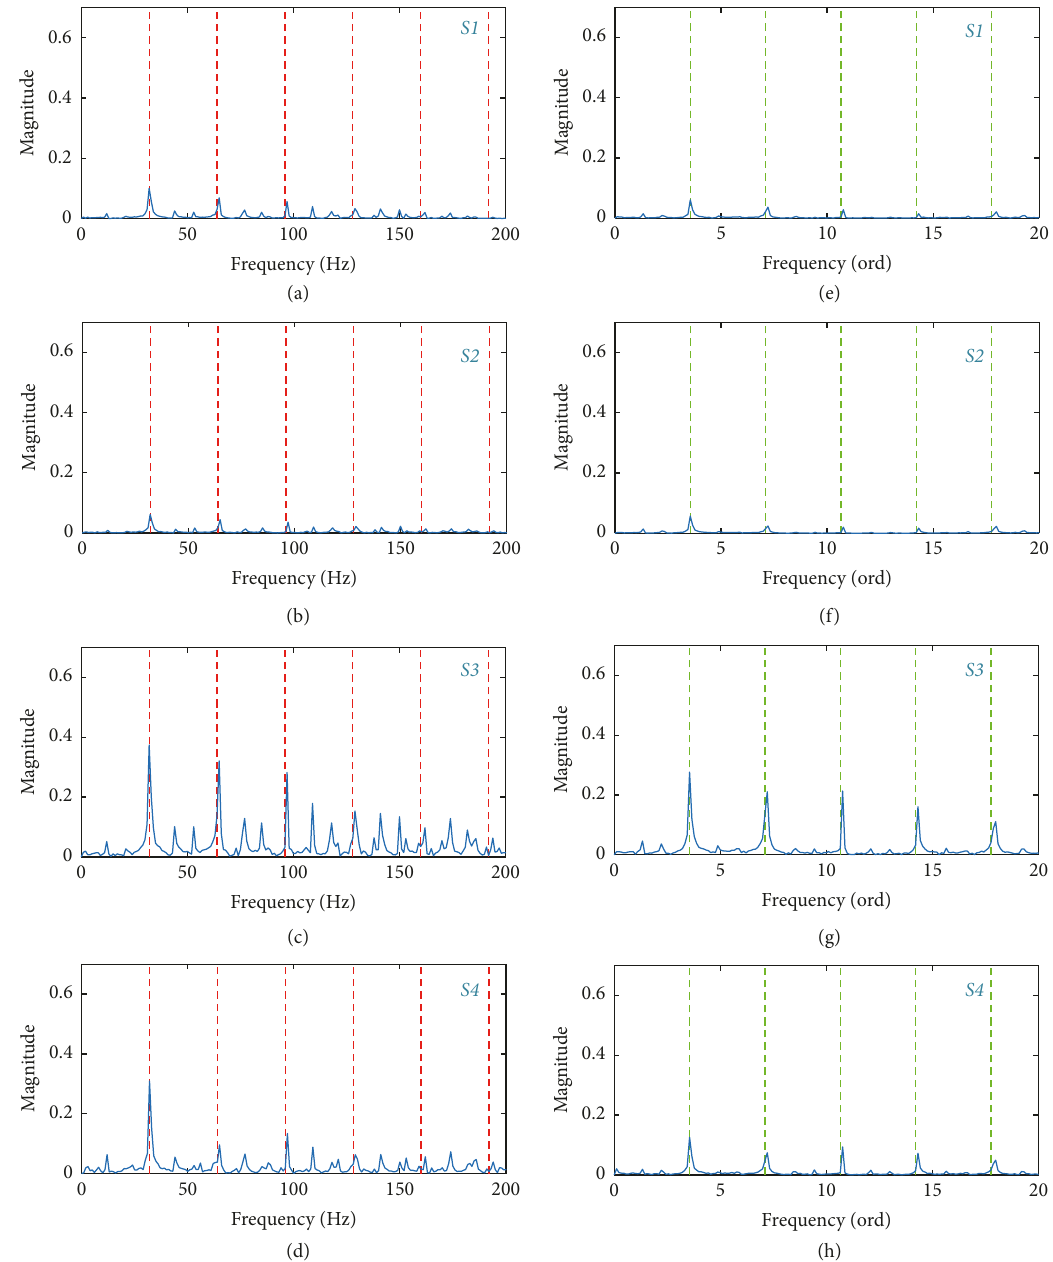
Figure 8: Envelope spectrums (a–d) and envelope order spectrums (e–h) for the time domain signals in Figure 7, respectively, from (a) to